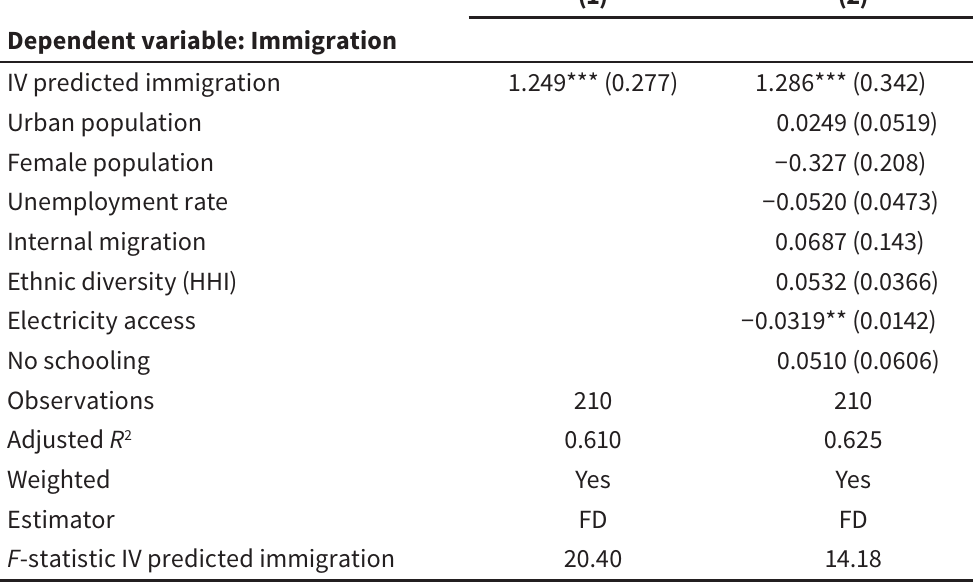
First stage results